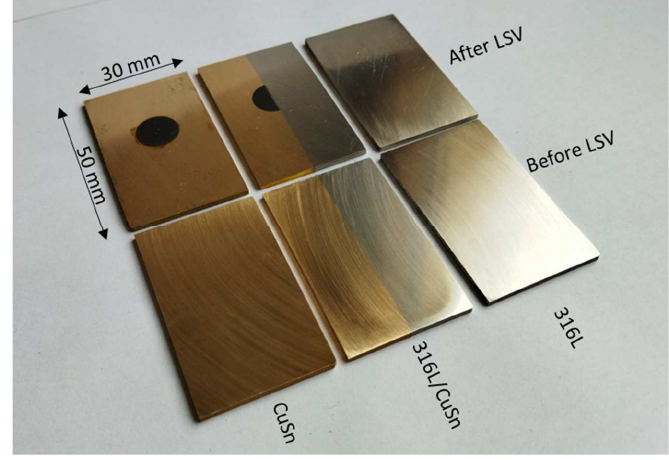
Figure 4. Manufactured and post-processed AM samples before and after an LSV measurement.